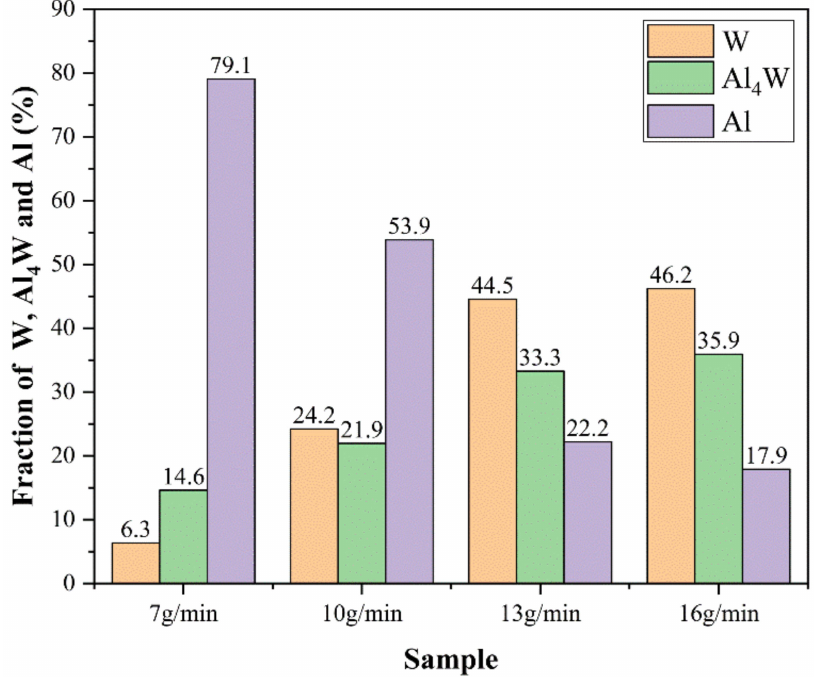
Figure 8. Area fraction of W, Al 4 W, and Al alloy in the W/Al composite layer.